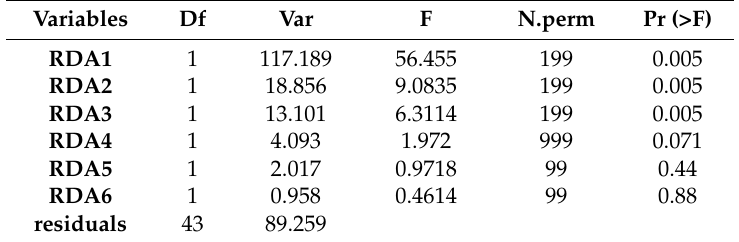
Table 5. Calculations of the statistical permutation test performed on the canonical